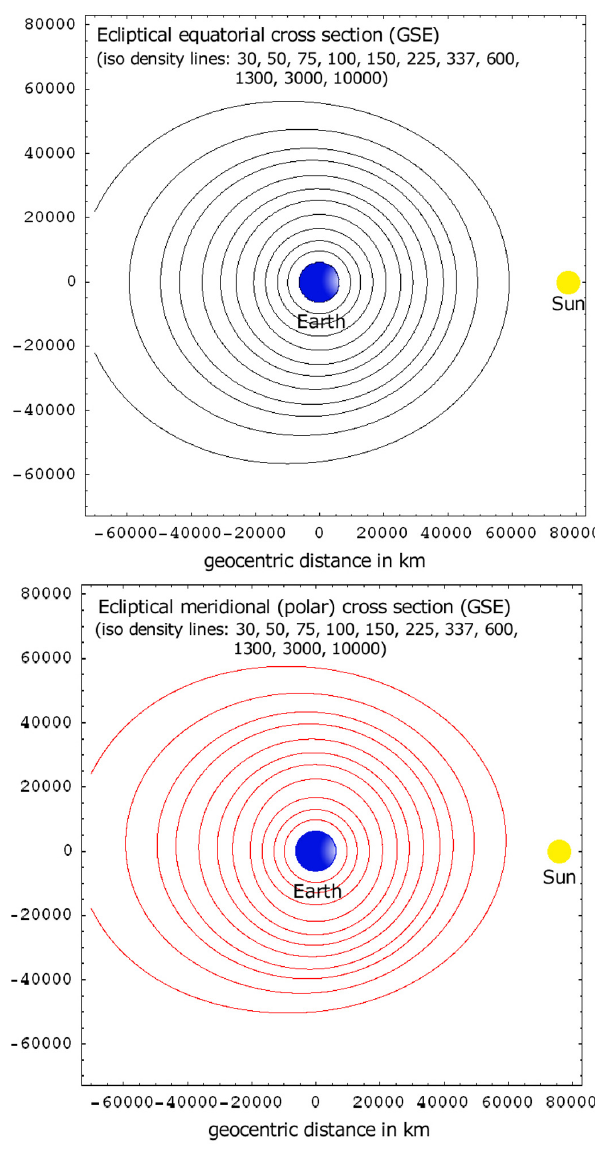
Fig. 5. Ecliptic equatorial and -meridional cross sections of the H- density